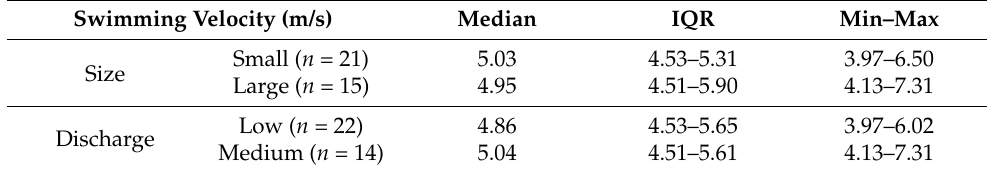
Table 2. Swimming velocity (m/s) of successful ascent events recorded in the Bercimuelle weir. Size classes based on fish smaller or larger than 25 cm length. Flow rate classes based on discharge lower or higher than 6.5 m 3 /s (IQR = interquartile range; n = number of fish). Swimming Velocity (m/s) Median IQR Small ( n = 21) Size